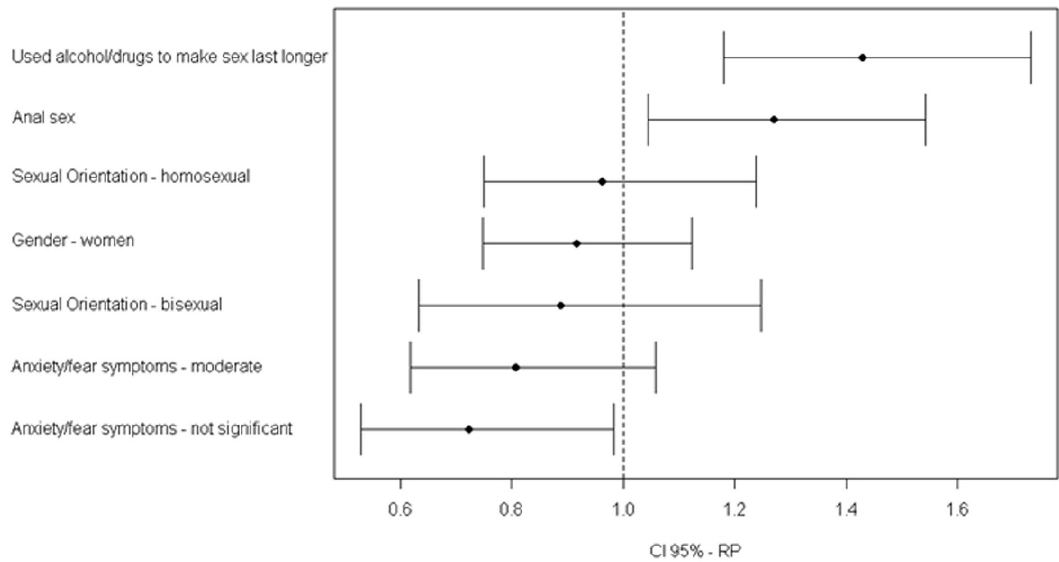
Figure 1 - Multivariate analysis shows that anal sex (PR=1.27; 95% CI: 1.044–1.543; p =0.017), use of alcohol/drugs to make sex last longer (PR=1.430; 95% CI: 1.181–1.732; p , 0.001), and anxiety/fear symptoms (PR=0.724; 95% CI: 0.532–0.983; p =0.039) are associated with